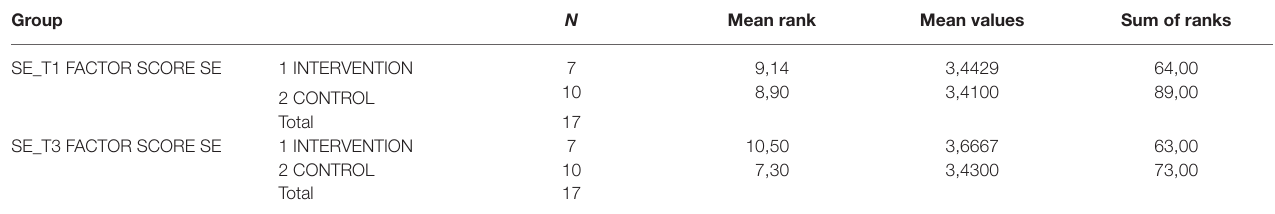
TABLE 3 | Ranks table.